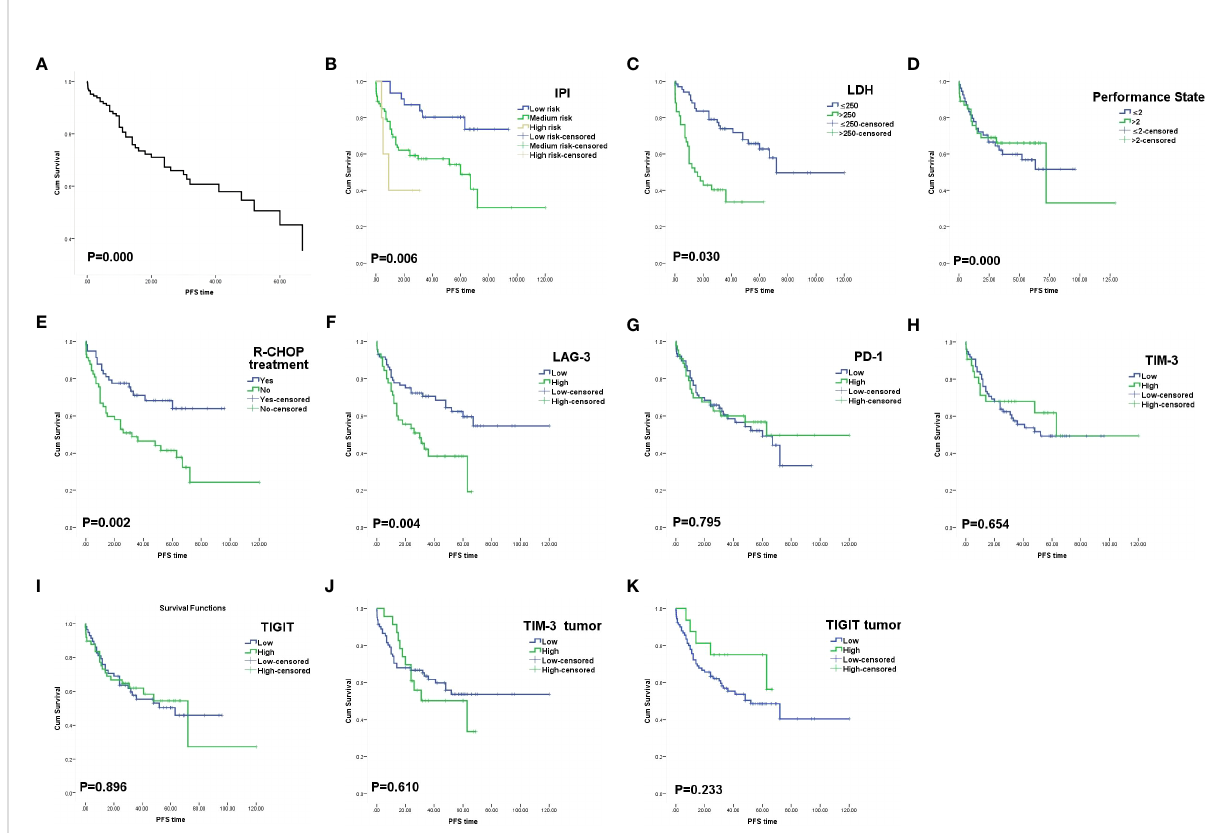
FIGURE 3 Progression free survival curves. (A) The progression free survival COX survival curves of these 174 patients with DLBCL. (B) Survival curves of patients according to IPI index. (C) Survival curves of patients according to LDH. (D) Survival curves of patients according to PS score. (E) Survival curves of patients according to R-CHOP treatment. (F) Survival curves of patients according to LAG-3 expression on TILs. (G) Survival curves of patients according to PD-1 expression on TILs. (H) Survival curves of patients according to TIM-3 expression onTILs. (I) Survival curves of patients according to TIGIT expression on TILs. (J) Survival curves of patients according to TIM-3 expression on tumor cells. (K) Survival curves of patients according to TIGIT expression on tumor